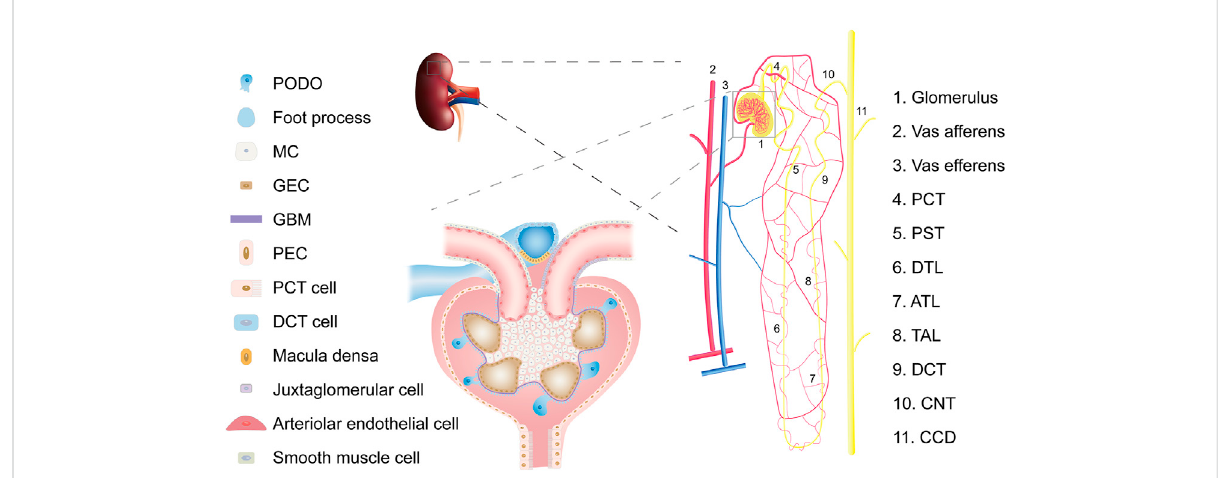
FIGURE 2 Overviewofkidneycelltypes.Abbreviations:PCT,proximalconvolutedtubule;PST,Proximalstraighttubule;DTL,descendingthinlimbofloop of Henle; ATL, ascending thin limb of loop of Henle; TAL, thick ascending limb of loop of Henle; DCT, distal convoluted tubule; CNT, connecting tubule; CD, collecting duct; PODO, podocyte; MC, mesangial cell; GEC, glomerular endothelial cell; GBM, glomerular basement membrane; PEC, parietal epithelial